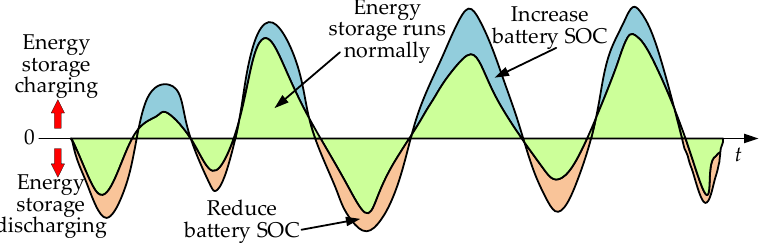
SOC regulation of the battery. Figure 4. Schematic of the charge/discharge energy of the SOC Ba regulation of the battery. Ba